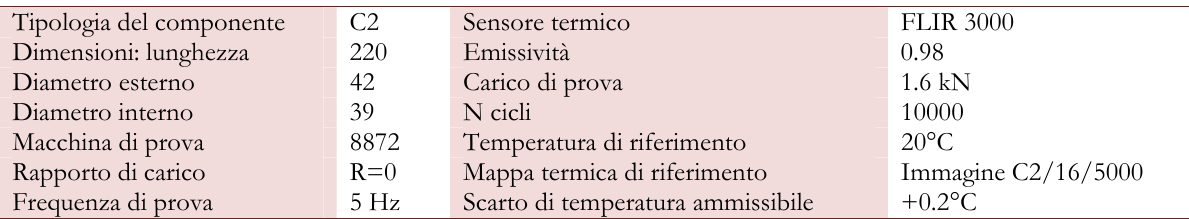
Tabella 1: Parametri di riferimento per il controllo di